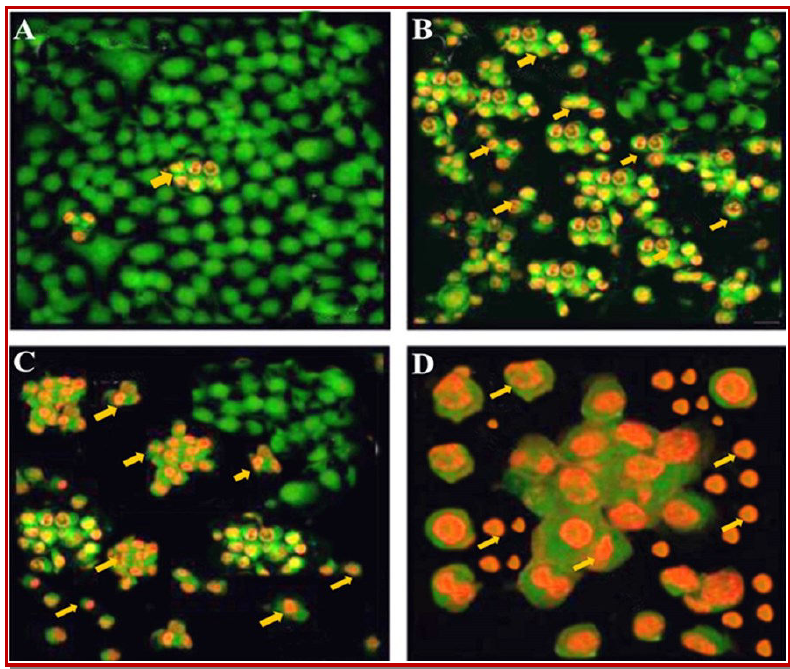
Figure 4: Apoptotic cell death induced by OAMVE in HeLa cervical cancer cells was evaluated by confocal fluorescence micros- copy. The cells were stained with AO and PI and observed using confocal microscope (x 400). HeLa cells were treated without (A) and with 15 µM (B), 60 µM (C) and 120 µM (D) of OAMVE for 48 hours; Yellow arrows represent apoptotic